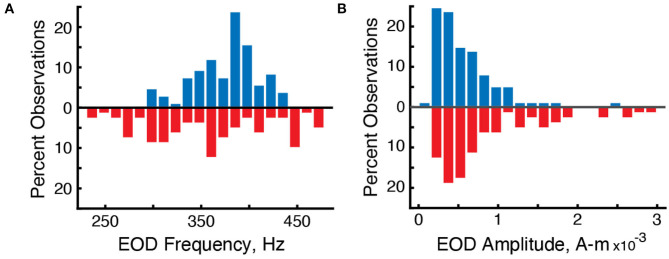
Differences in the distribution of EOD frequencies and amplitudes in surface fish (blue, up) and cavefish (red, down). (A) Percent observations of EOD frequencies for surface fish and cavefish. (B) Percent observations of EOD amplitudes.